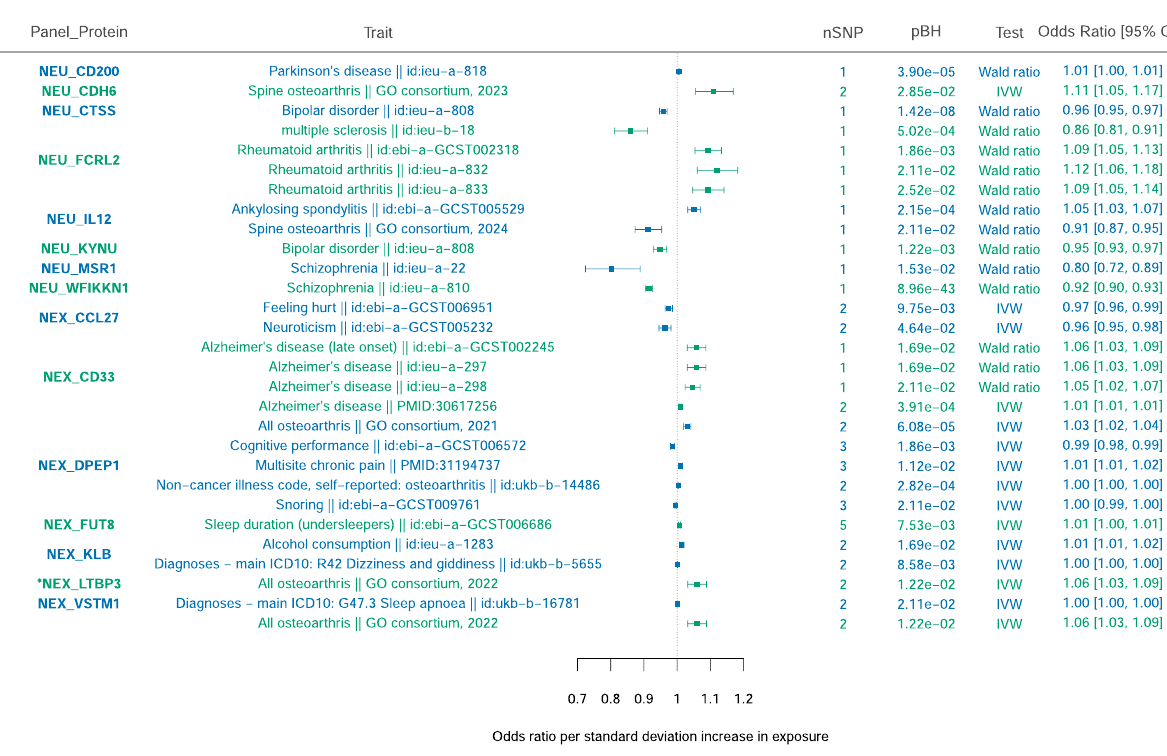
Fig. 3 Causal protein-disease associations identi fi ed using two-sample Mendelian randomisation. We investigated the causal effect of serum proteins (exposure) on various neurological traits (outcome), indicated in the fi rst two columns in the plot. PubMed IDs (PMIDs) are given where manually downloaded summary statistics were used; other IDs are those as given in MRBase (https://gwas.mrcieu.ac.uk/). The number of variants used in the analysis are given in the ‘ nSNP ’ column. The ‘ pBH ’ column contains the FDR-adjusted (Benjamini – Hochberg) P -value for each test. Protein – trait pairs with only one variant were analysed using the Wald ratio method, while those with more than one variant were analysed using the inverse variance-weighted (IVW) method. Data are represented as mean odds ratio ± SEM. *Additional signal arising from analysis using only cis -pQTLs as instrumental